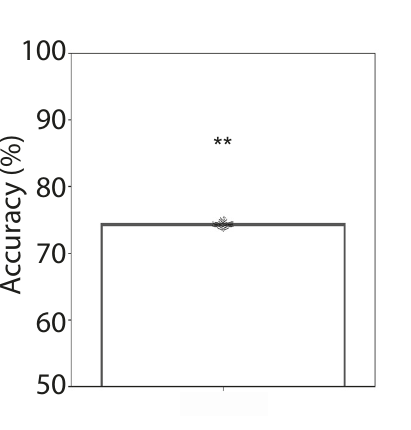
Fig. 4 Dynamic causal in fl uences distinguish working-memory conditions. Linear SVM analyses with 10-fold cross-validation revealed that dynamic causal in fl uences between SN, FPN, and DMN nodes distinguished the 2-back and 0-back working-memory task conditions ( p s < 0.01, permutation